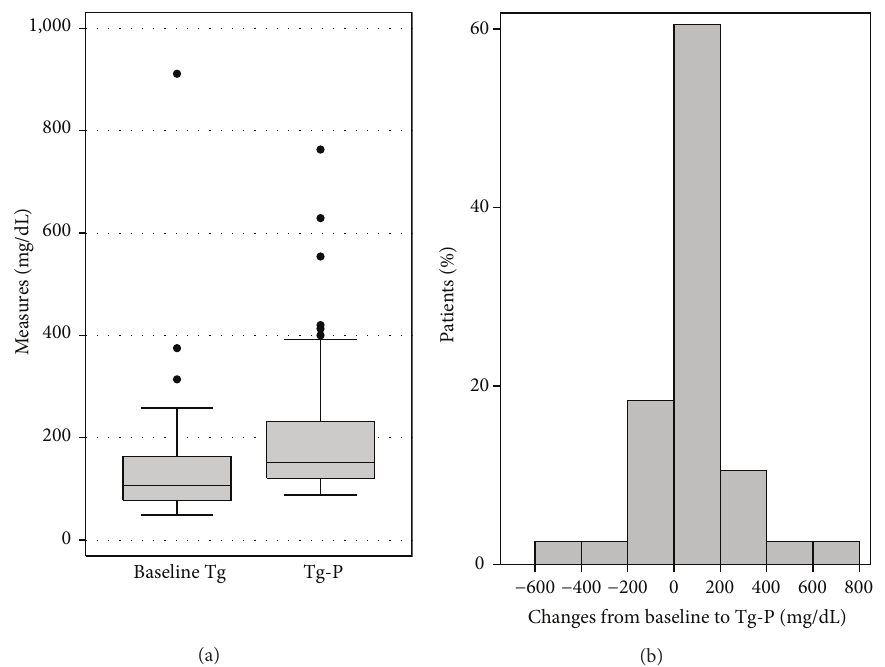
Figure 4: (a) Box plot illustrating triglyceride levels at baseline (baseline Tg) and the peak triglycerides during mitotane therapy (Tg-P). Mean baseline Tg was 149.0 mg/dL and mean Tg-P was 216.7 mg/dL ( 𝑃 = 0.042 ). (b) A histogram showing the distribution of within-patient triglyceride